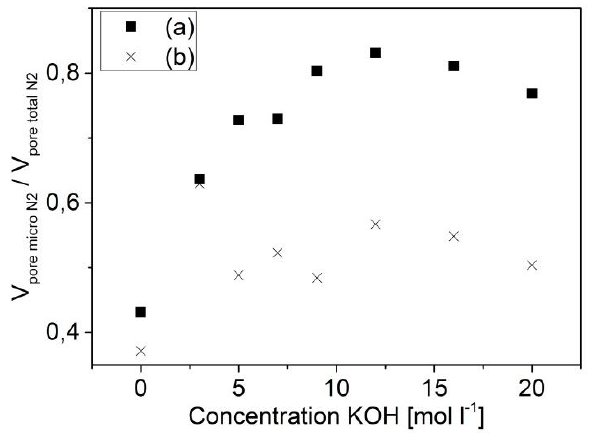
Figure 7. Ratio of micropore volume to total pore volume (micropore fraction) in dependence on the concentration of the used activation agent: series 873- x (a) and series 1173- x (b).